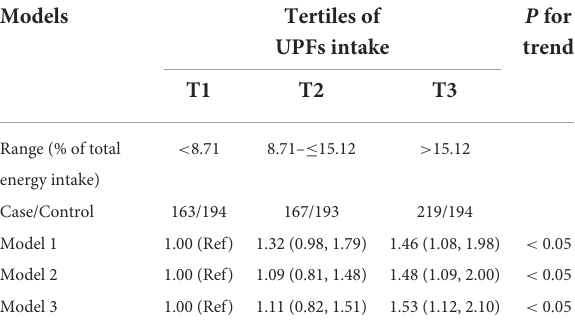
TABLE 2 Adjusted odds ratio (95% confidence interval) of ultra-processed foods intake and asthenozoospermia.